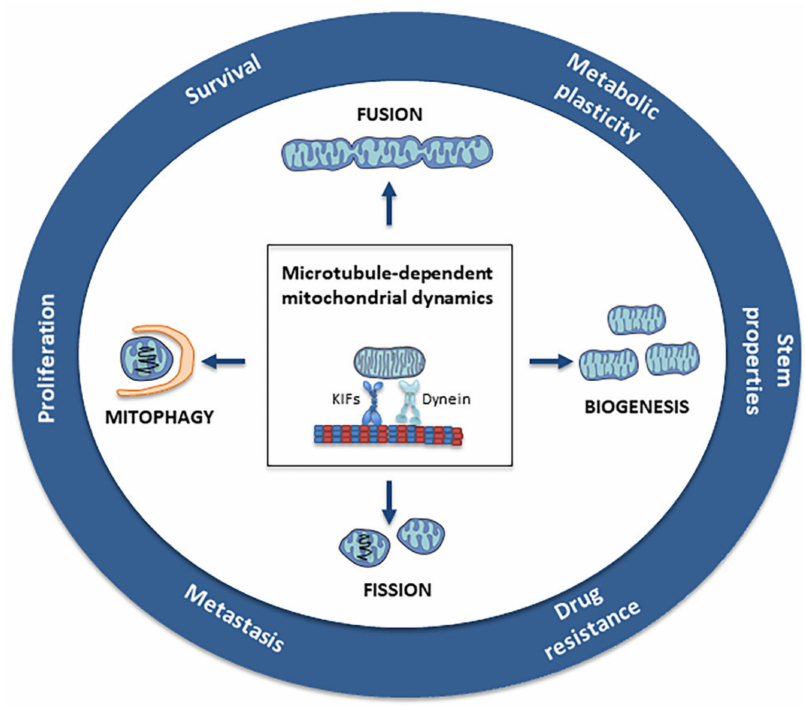
Figure 1. Microtubule-dependent mitochondrial dynamics: Through the balance between fu- sion/fission and biogenesis/mitophagy, mitochondrial dynamics represent a central process in the bioenergetic adaptation and metabolic plasticity of cancer cells. The balance between biogenesis and mitophagy regulates the number of mitochondria and their quality. The fusion process helps to increase mitochondrial metabolism and to limit mitophagy and apoptosis, while the fission process allows the spatial redistribution of mitochondria in areas of the cell with greater energy and metabolic needs, favoring cell spreading and